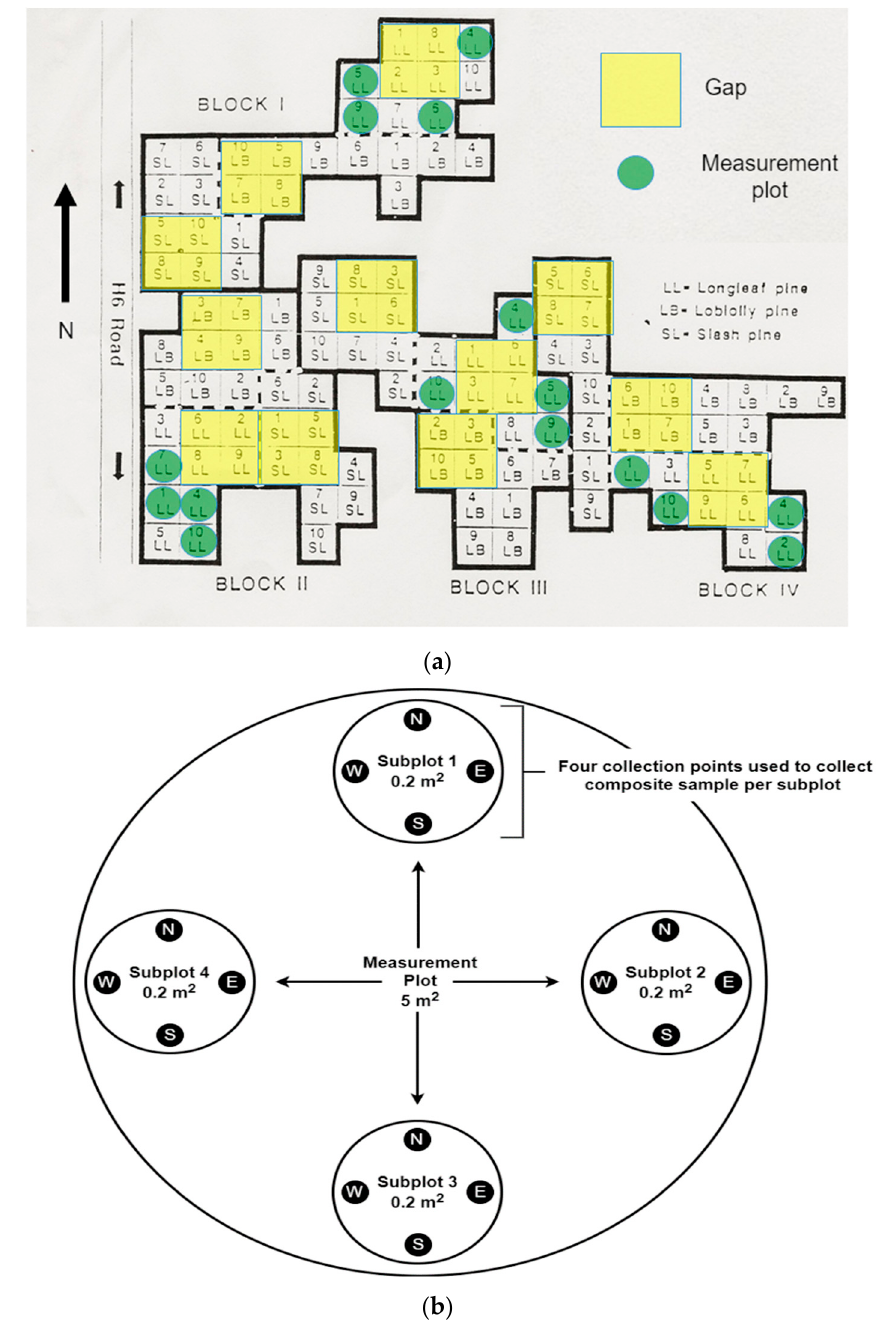
Figure 1. Map of study site at the Harrison Experimental Forest near Saucier, Mississippi, where green circles denote the location of 16 measurement plots and yellow squares identify 12 gaps that were harvested ( a ). Within each 5 m 2 measurement plot, four 0.2 m 2 subplots were located 1 m from center ( b ).